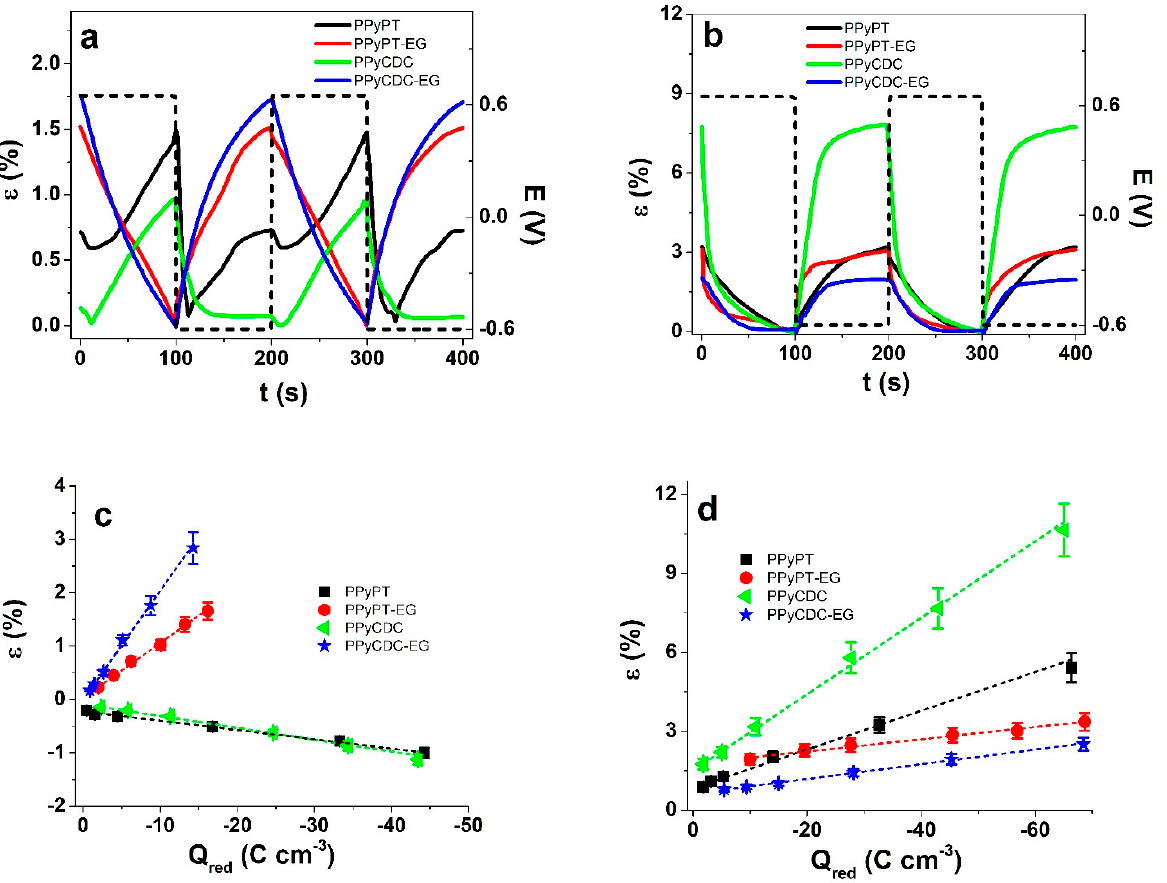
Figure 5. Square potential step measurements of PPyPT (black line, ■ ), PPyPT-EG (red line, ● ), PPyCDC (green line, ◄ ) and PPyCDC-EG (blue line, ★ ) showing the strain ε at frequency 0.005Hz of two subsequent cycles (2 nd to 3 rd ) in ( a ), NaClO 4 -PC electrolyte and in ( b ), NaClO 4 -aq electrolyte at applied potential range E (dashed line), in ( c ), the strain ε against charge density Q red at reduction in NaClO 4 -PC are presented and in ( d ), in NaClO 4 -aq are shown The dashed lines in c and d represent the linear fit and are shown here for orientation, only.